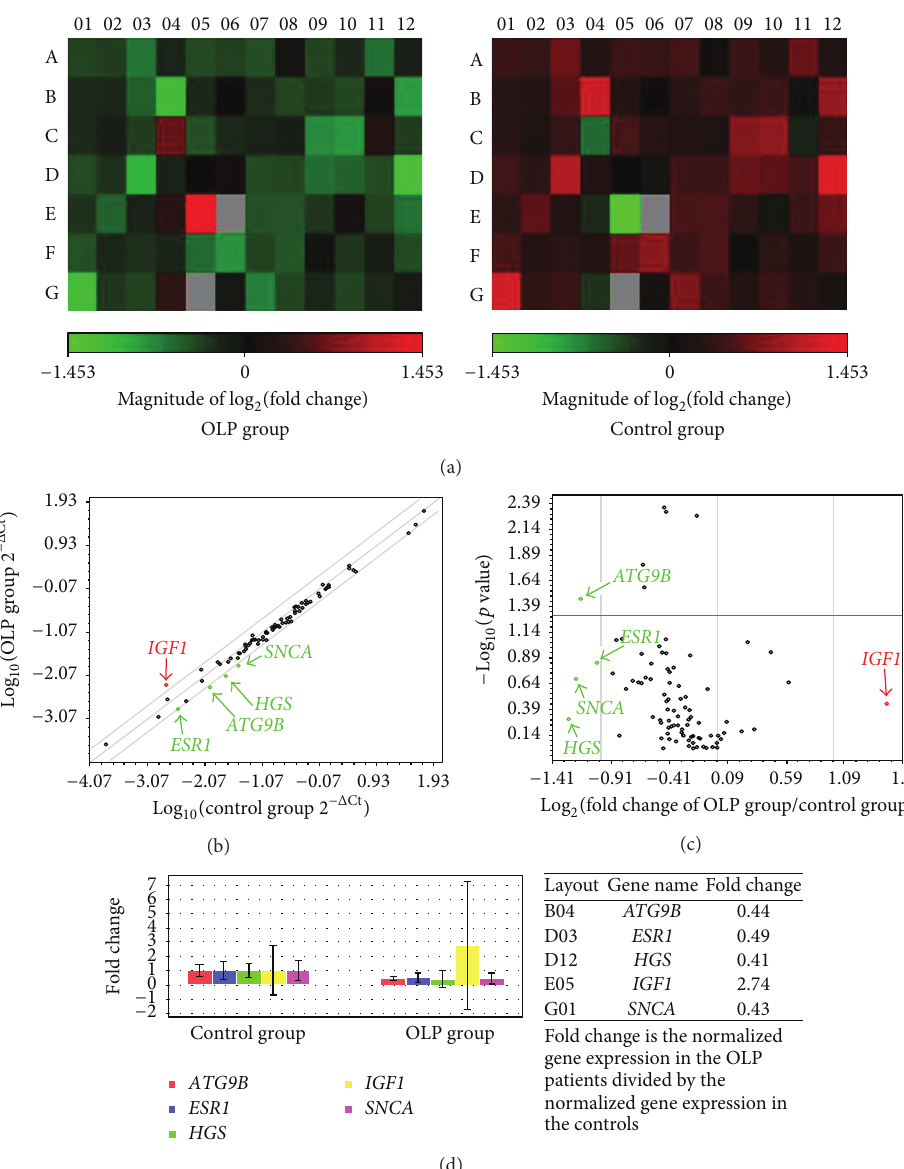
Figure 1: Different expression of autophagy-associated genes in T cells of OLP. (a) Heat plot displayed different expression of autophagy- associated genes in peripheral blood T cells from OLP patients and controls. (b) Scatter plot showed expression of autophagy-associated genes, with a fold difference of 2. (c) Volcano plot showed the significant difference in expression of autophagy-associated genes on T cells between OLP patients and control individuals. Fold change and fold regulation bigger than 2 were highlighted in red; fold change less than 0.5 and fold regulation less than − 2 were highlighted in green. (d) Multianalysis displayed obvious overexpressed IGF1 mRNA and decreased expression of ATG9B , HGS , ESR1 , and SNCA in T cells of